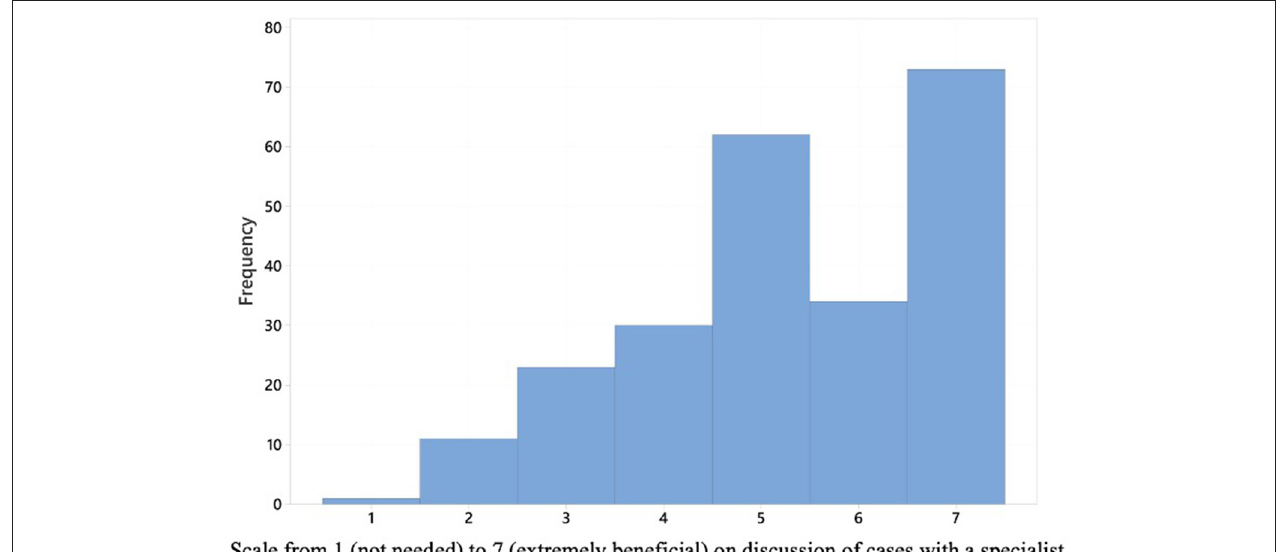
FIGURE 5 | A histogram displaying how the 235 respondents scored on a scale from 1 (not needed) to 7 (extremely beneficial) how beneficial would it be for them to be able to discuss canine idiopathic epilepsy cases with a specialist in veterinary